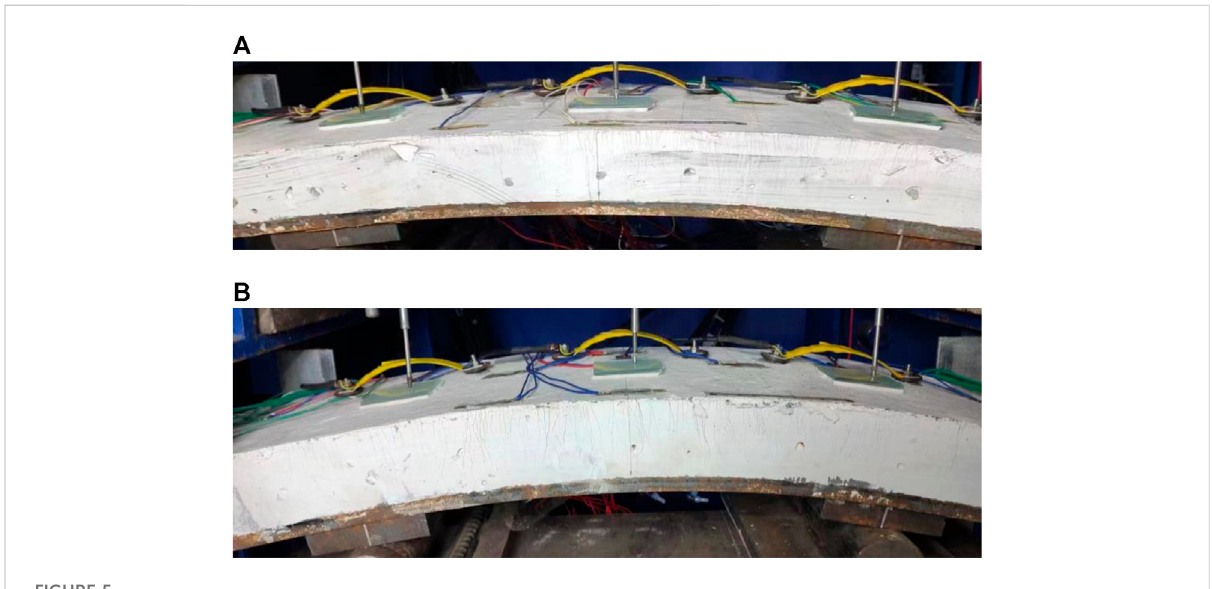
FIGURE 5 Crack distribution of (A) BE0 at 40 kN and (B) BE1 at 80